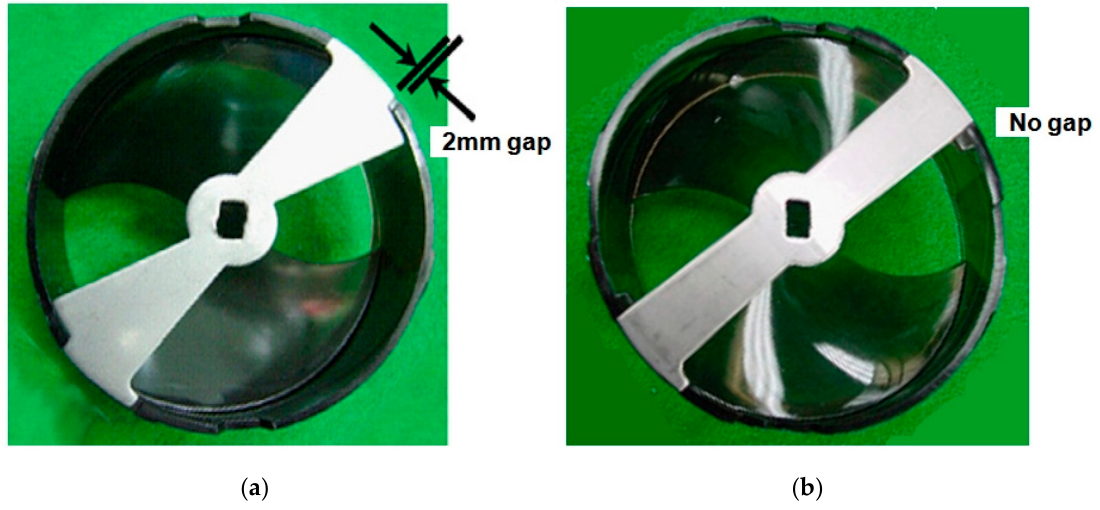
Figure 10. Field data and results of ALT on Weibull chart.